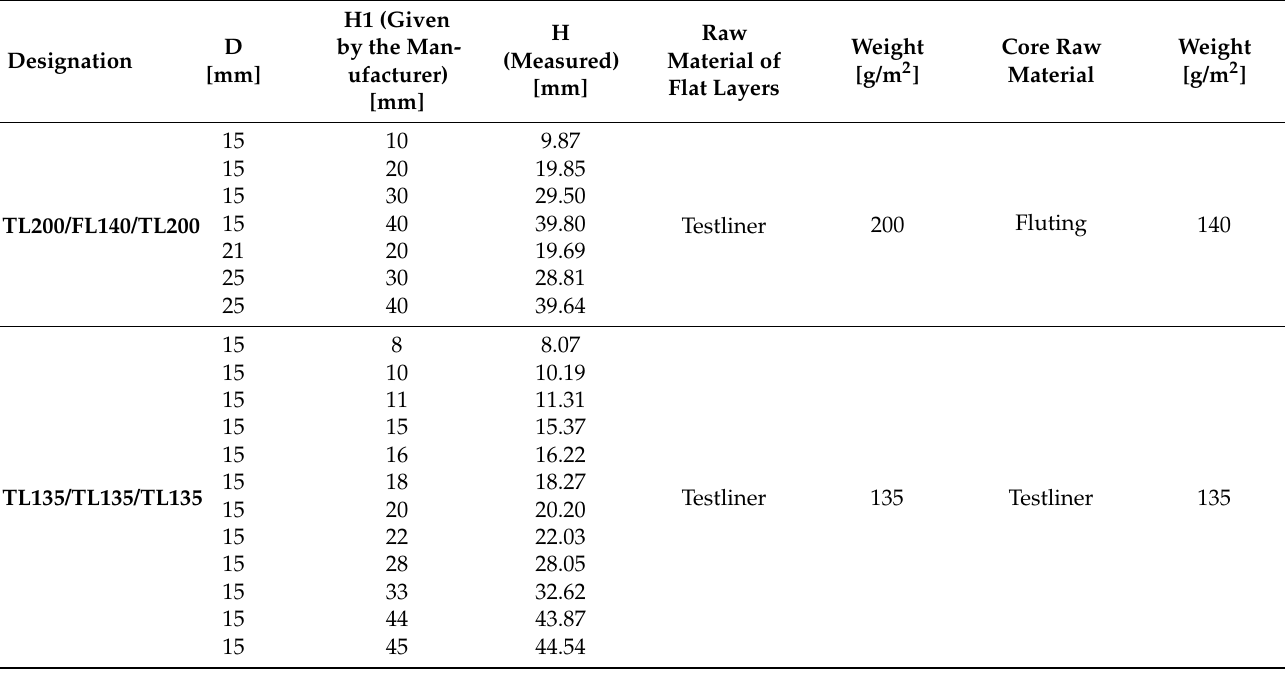
Table 1. Characteristics of the tested honeycomb paperboards.